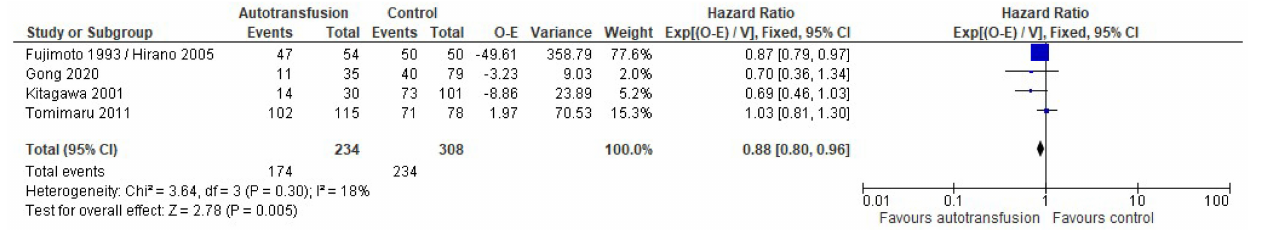
Figure 5. Forest plot for disease-free survival in hepatectomy patients with autotransfusion and without. Blue squares indicate individual effects and black diamond illustrates overall effect.